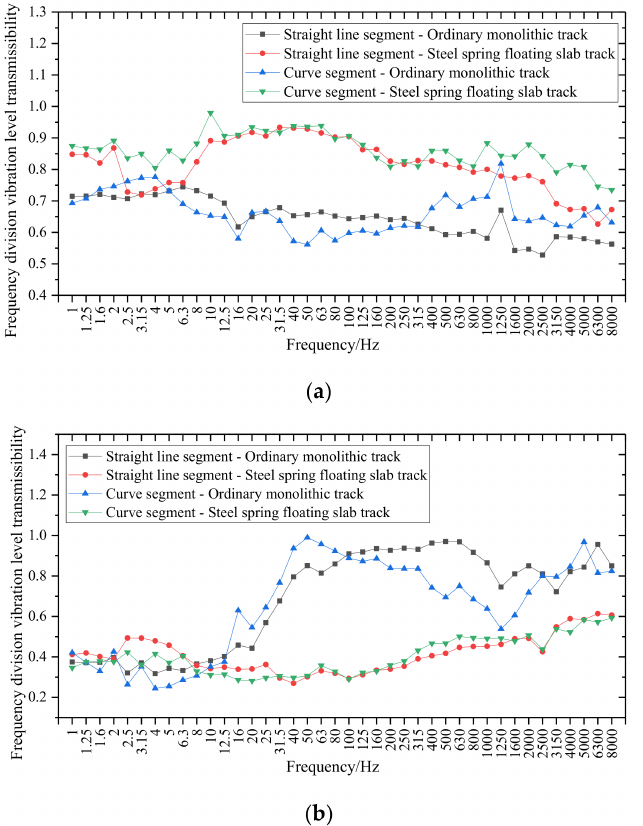
Figure 21. Comparison of frequency division vibration level transfer rate of each track component. ( a ) Rail–track bed; ( b ) Track bed–tunnel